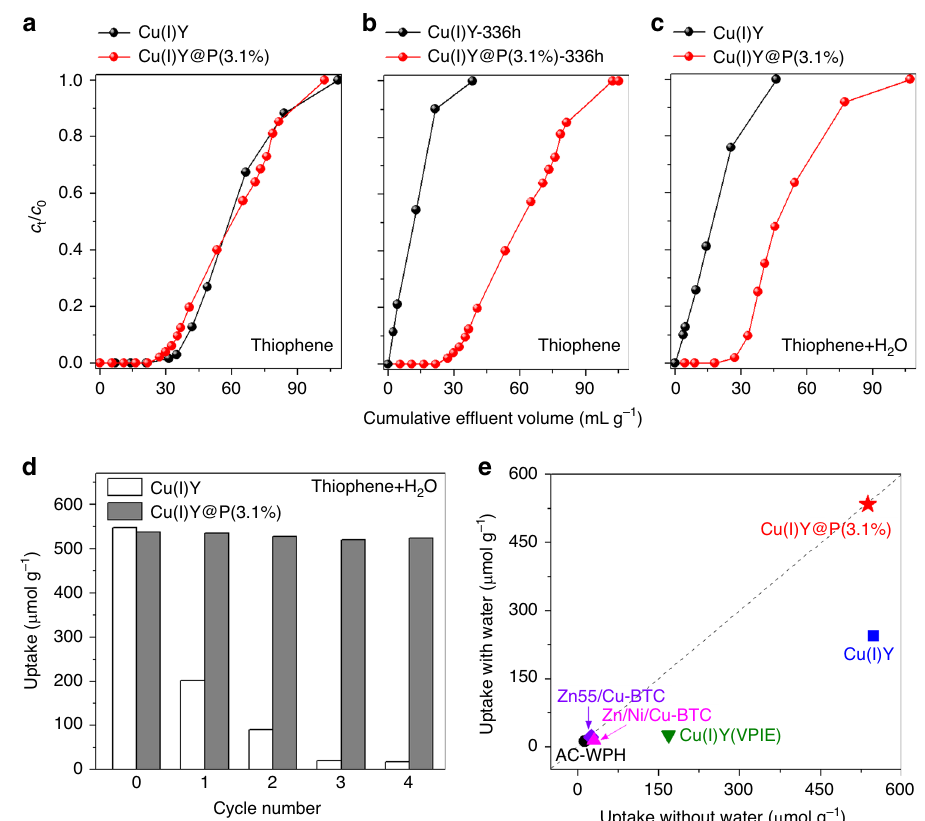
Fig. 4 Adsorptive desulfurization performance. Breakthrough curves of the model fuel containing 550 ppmw thiophene over Cu(I)Y and Cu(I)Y@P(3.1%) a before and b after exposure to humid atmosphere (RH = 75%) for 336 h; c Breakthrough curves of the model fuel containing 550 ppmw thiophene with the addition of 300 ppmw H 2 O over Cu(I)Y and Cu(I)Y@P(3.1%); d Recyclability of Cu(I)Y and Cu(I)Y@P(3.1%) in the model fuel containing 550ppmw thiophene with addition of 300 ppmw H 2 O; e Comparison of desulfurization capacity of different adsorbents in the fuels with and without addition of H 2